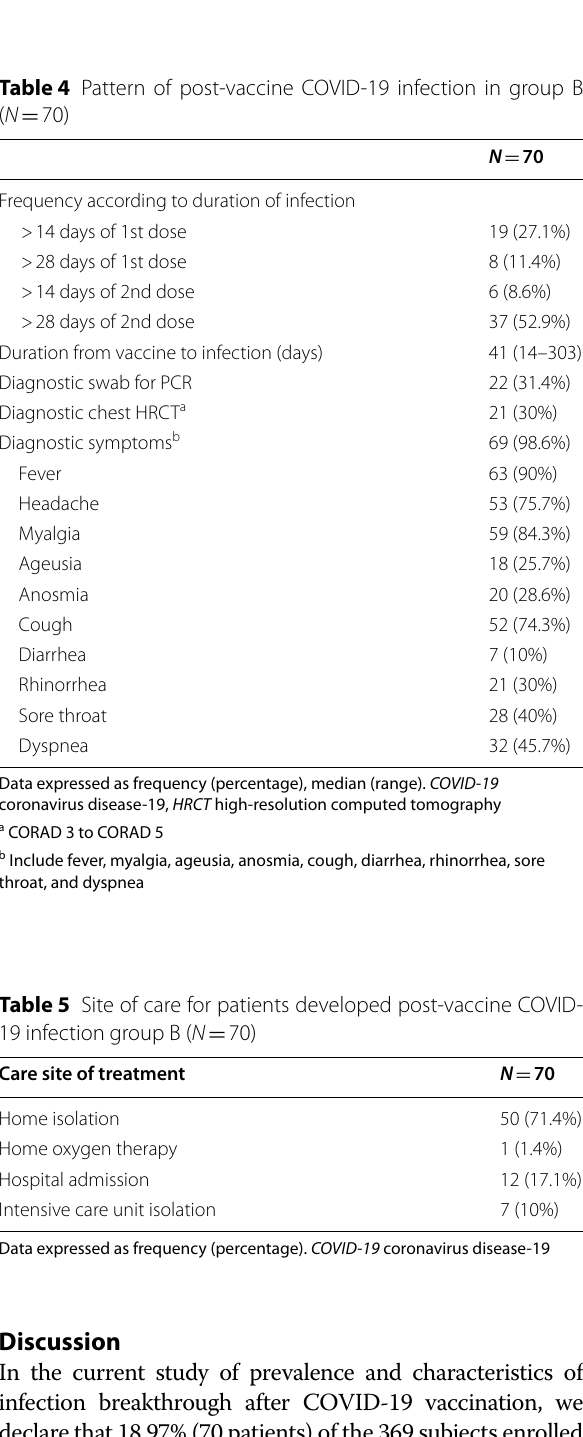
Table 4 Pattern of post-vaccine COVID-19 infection in group B